Question: Describe this figure in one sentence.
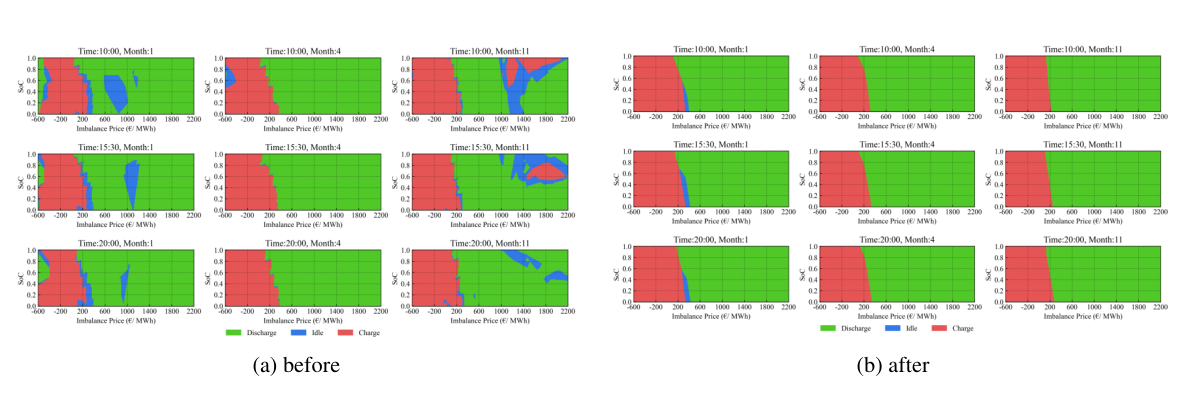
Answer: illustrates how the policy correction step improves the performance by showing the DDQN policy heatmaps before and after applying the policy correction step. As the most determinative features for the DDQN agent are indicative imbalance prices and SoC, we plot the learned policy with respect to these two input features for various times and months. It can be observed that the learned policy in some areas does not align with human intuition. For instance, there is a significant idle/ charge area in the policy for the 11th month at 10:00 when the price exceeds 1000